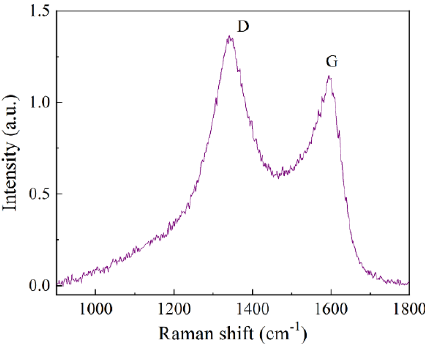
4 of 14 Figure 3. Result of TGA and differential thermal (DTA) study of Fe@C nanoparticles. The mass variation Δ m is the joint result of two processes: core oxidation (gain) and carbon combustion (loss). In the temperature range of 150 – 200 °C, these two processes more or less compensate each other. Then, rapid increase in mass begins. As the shell already passes oxygen well, intensive core oxidation is triggered, which is accompanied by an increase in volume followed by an even greater shell destruction. Further, the shell fragments begin to combust, which leads to a decrease in mass, because the formed CO 2 exudes together with carbon. Even in the case of ongoing core oxidation, the rate of weight gain is already less than the rate of weight loss caused by the shell combustion. After the combustion of the entire composite, a slight decrease in the sample mass occurs, since the loss of the mass caused by the exuded carbon exceeds the gain caused by the core oxida- tion. The content of carbon has been obtained by the following method. The mass of the sample M FeC before heating in air. After heating at 1000 °C, whole carbon burns down and Fe 2 O 3 oxide appears. Then, the sample is weighted again. The mass of iron M Fe is defined according to the chemical formula, namely 69.9% from the mass of Fe 2 O 3 oxide. If one subtracts the mass M Fe from the primary M FeC mass, then they obtain the carbon mass con- tained in the FeC sample. As a result, the carbon concentration is found to be 32 wt.%. Raman spectrum in the region of 1000 – 2000 cm −1 contains two lines-D and G near 1340 and 1590 cm −1 ; see Figure 4. In order to estimate the parameters of the carbon envelope, the Raman spectra have been measured for the Fe@C nanocomposite. These spectra have been compared to the spectra of the different carbon materials from graphite to diamond- like carbon films with high content of the tetrahedral bonds [20]. In addition to the main